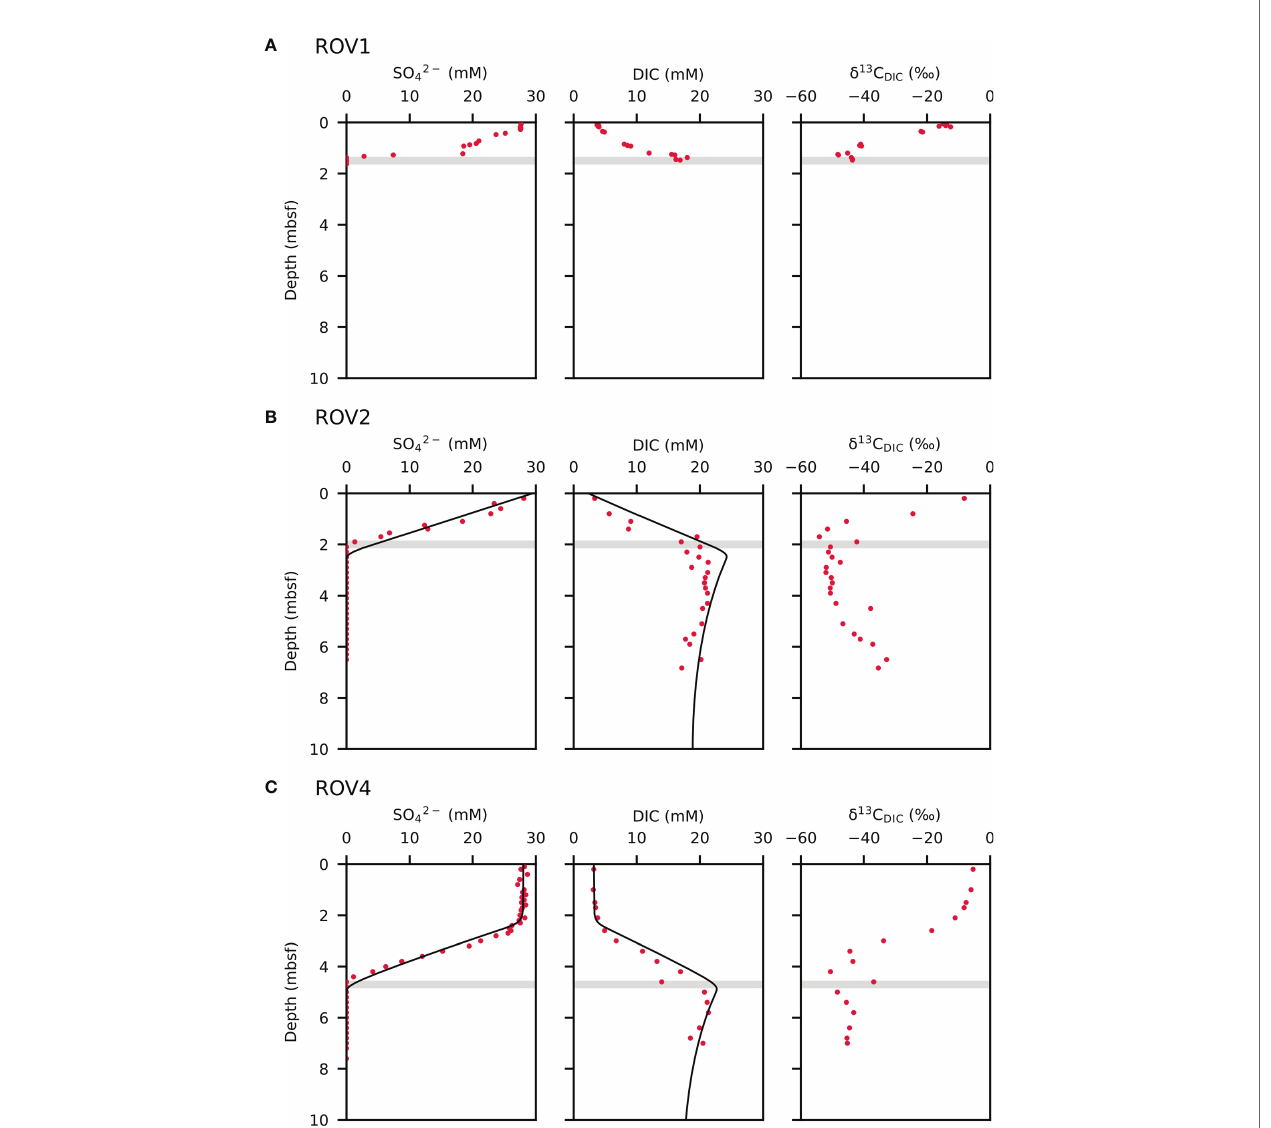
FIGURE 2 | Pore water pro fi les of sulfate (SO 2 − 4 ) and dissolve inorganic carbon (DIC) concentrations and d 13 C DIC values for cores ROV1 (A) , ROV2 (B) , and ROV4 (C) . Dots are measured data and solid lines are model results. The “ mbsf ” refers to meters below sea fl oor. The shaded bar marks the sulfate-methane transition zone